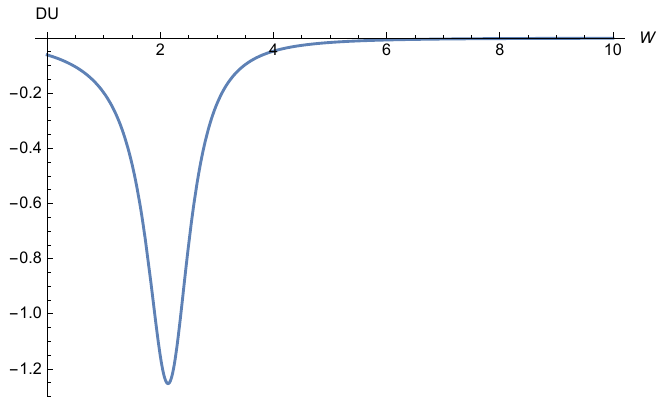
Figure 8. DU ( W ) δ = 0.1, a = 0.5 .